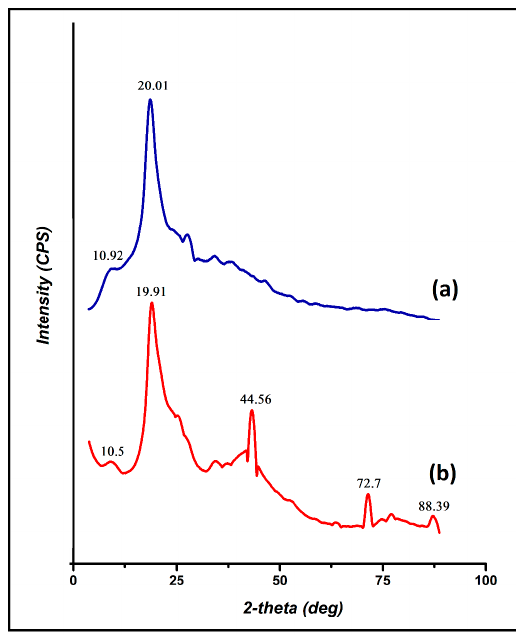
Figure 2. XRD patterns of ( a ) chitosan and ( b ) CCA.